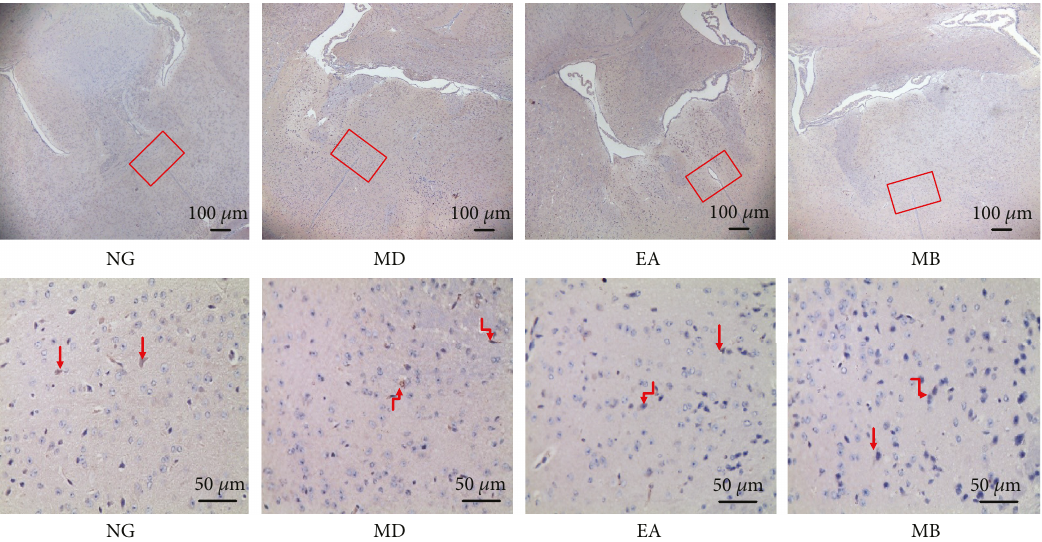
Figure 7: The expression of CRH in the hypothalamus was detected by the immunohistochemical method. The red square was the paraventricular nucleus (PVN), and red arrows were the positive cells of CRH in the PVN. NG: normal group; MD: model group; EA: electroacupuncture group; MB: moxibustion group. CRH: corticotropin-releasing hormone (magni fi cations — up: 40x, down: 400x, and scale bar =50 micron).